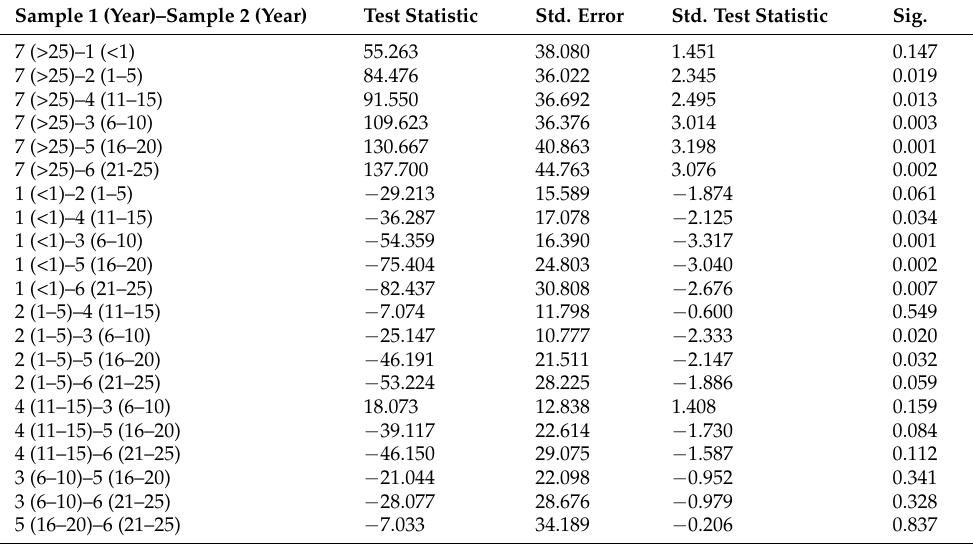
Table 11. Post-hoc pairwise test with null hypothesis: Sample 1 and sample 2 distribution are the